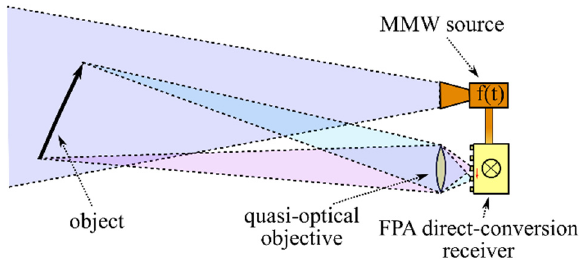
Figure 1. A general representation of the imaging principle. A 2D image is formed by a quasi-optical objective, and the radial coordinate is determined by analyzing the phase of the beat frequency (BF) signal.